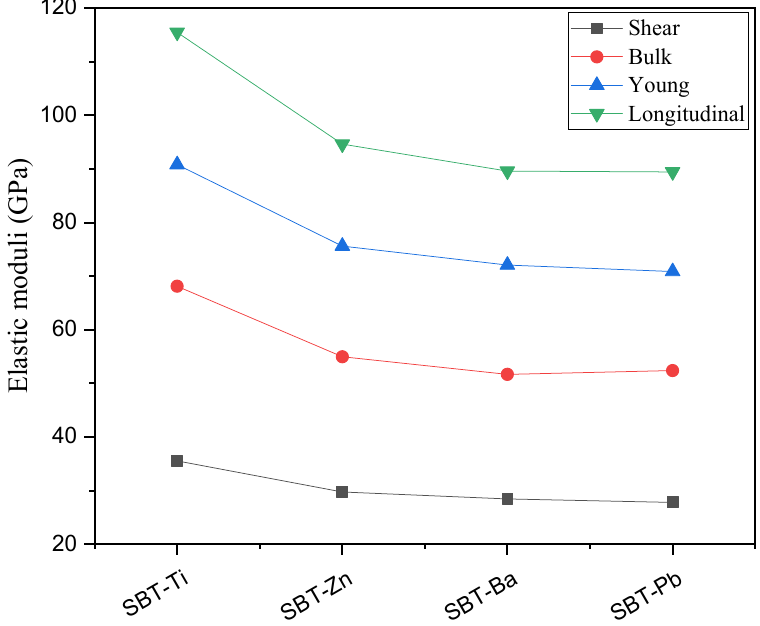
Figure 4. The relationship among the various elastic moduli of the fabricated SBT glasses. Commonly, the Poisson’s ratio of glassy complexes is affected by the alteration in its cross-link density which arises from the structural modification [20,32]. If the Poisson’s ratio lies in the range 0.1–0.2, the cross-link density will be high for the system with the better tightly packed structure to capture radiation [32]. For the present proposed glasses, the Poisson’s ratio lies in the range 0.268–0.278, depicting better cross-link density of the tiled glasses that signifies better shielding performance. From the table, the observed re- duction in the softening temperature (SBT-Ti > SBT-Zn > SBT-Ba > SBT-Pb) denotes the rise in the production of NBOn that causes a loosely bounded glass structure with reduced lattice vibrations. The micro-hardness usually depicts the essential stress to remove the glass matrix’s free volume (distortion of the system) [33]. The free volume denotes the loosely packed structure, which should be minimum for a shielding medium. Figure 5 portrays the correlation between Poisson and micro-hardness of the studied glasses that expresses higher values of the SBT-Ti glass, indicating reduced free volume and better compactness of the structure than other samples. The bond fractal connectivity is a vital feature relating the mechanical attributes of glasses to their networks. The effective di- mensionality and cross-link density of glassy systems can be expressed by means of bond fractal connectivity. The evaluated values may lie in the range of 1,2,3 for the chain, layer structure, and 3D structure depending upon the complexes. It is apparent from Table 2 that the assessed values lie in the range 2.087–2.201 for the as-polished samples symboliz- ing their 2D layer structure.